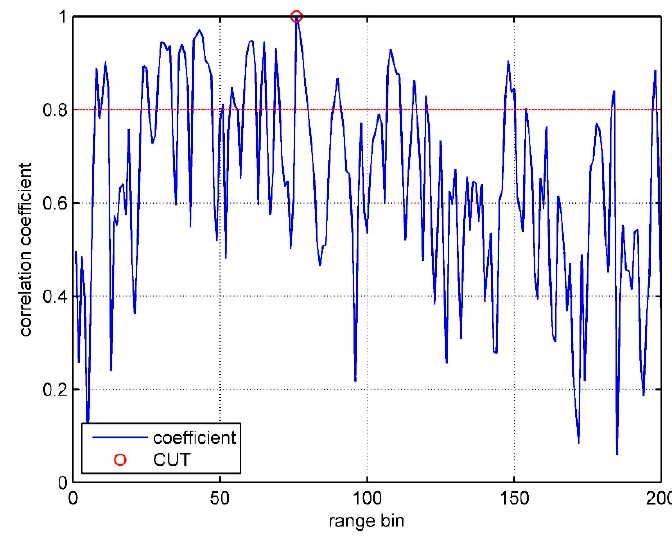
Figure 3. Range correlation result of first-order sea clutter, the Doppler frequency f = − 0.2602 Hz, beam point at b = 0 ◦ , reference range bin i = 76, and threshold is 0.8.